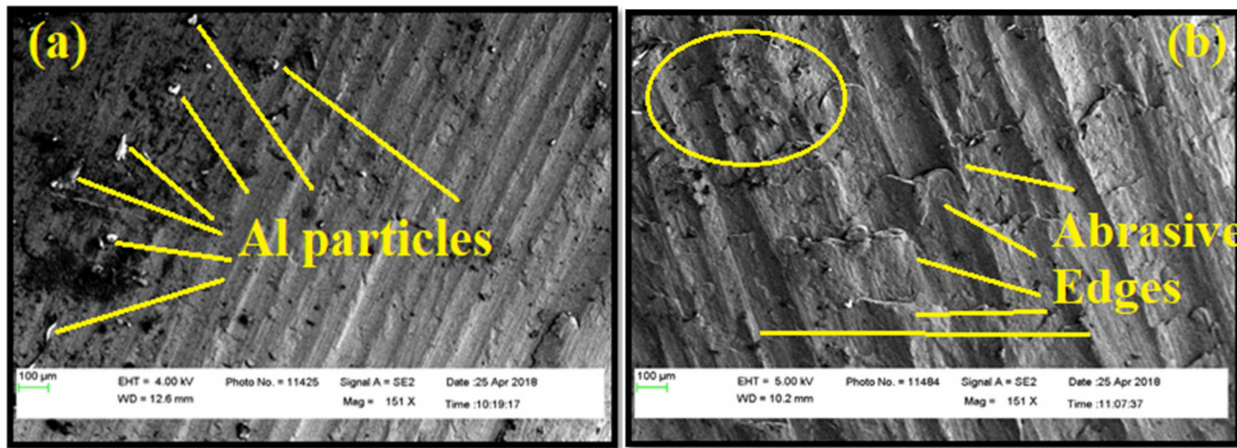
Figure 13. The morphologies for drilled surface: AA7075, 0 and 9 wt.% TiB 2 AMC at cutting speeds of 1000 and 1500 m/minute and feed rates of 0.05 and 0.15 mm/rev ( a ) FESEM morphology of AA7075/ 0 wt.% TiB 2 AMC at cut- ting speed 1500 m/minute and feed rate of 0.05 mm/rev and ( b ) morphologies for the drilled surface at a speed of 1000 m/minute and feed rate of 0.15